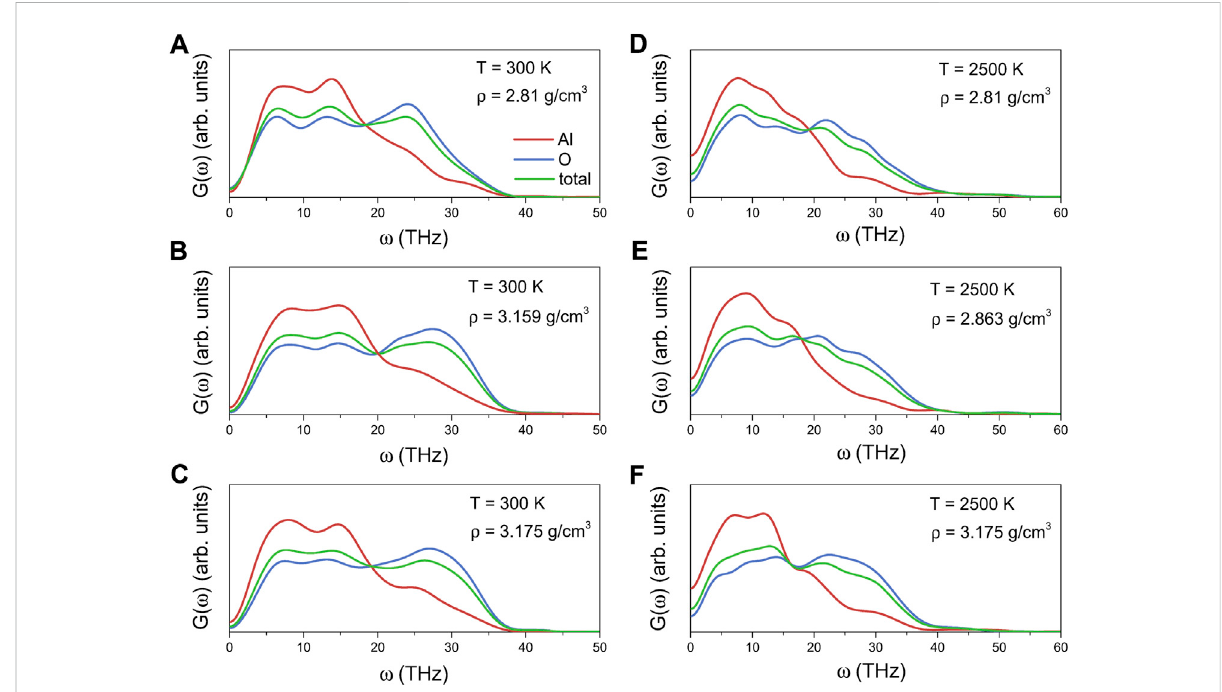
FIGURE 8 Totalandpartialvibrationaldensityofstatesforamorphousaluminaat300 K, (A) ρ =2.81 g/cm 3 , (B) ρ =3.159 g/cm 3 and (C) ρ =3.175 g/cm 3 ,and for liquid alumina at 2500 K, (D) ρ = 2.81 g/cm 3 , (E) ρ = 2.863 g/cm 3 and (F) ρ = 3.175 g/cm 3 .